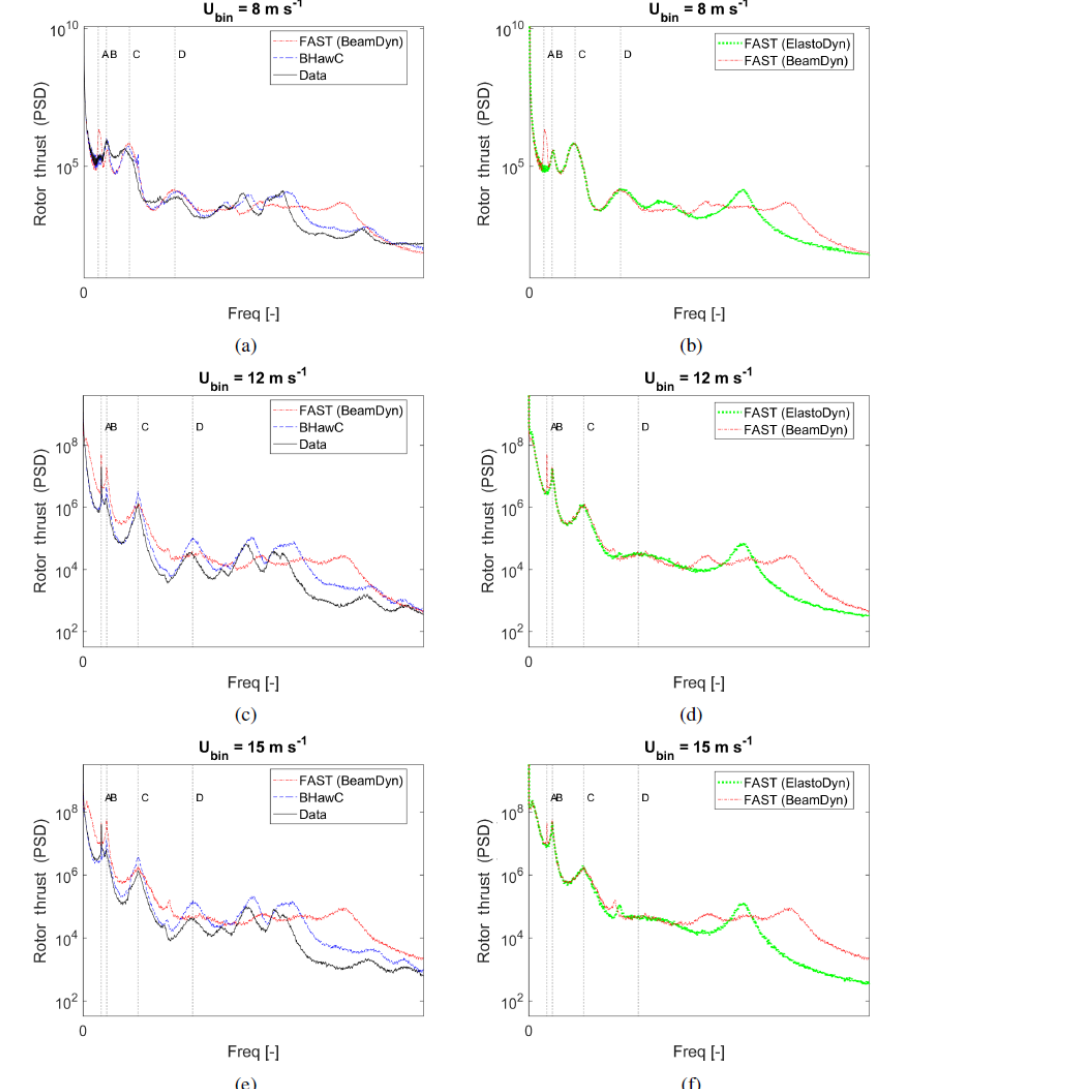
Figure 14. PSDs of the rotor thrust force. The three sets of graphs represent the ensemble-averaged PSDs from the inflow velocity bins at 8ms − 1 (top), 12ms − 1 (center), and 15ms − 1